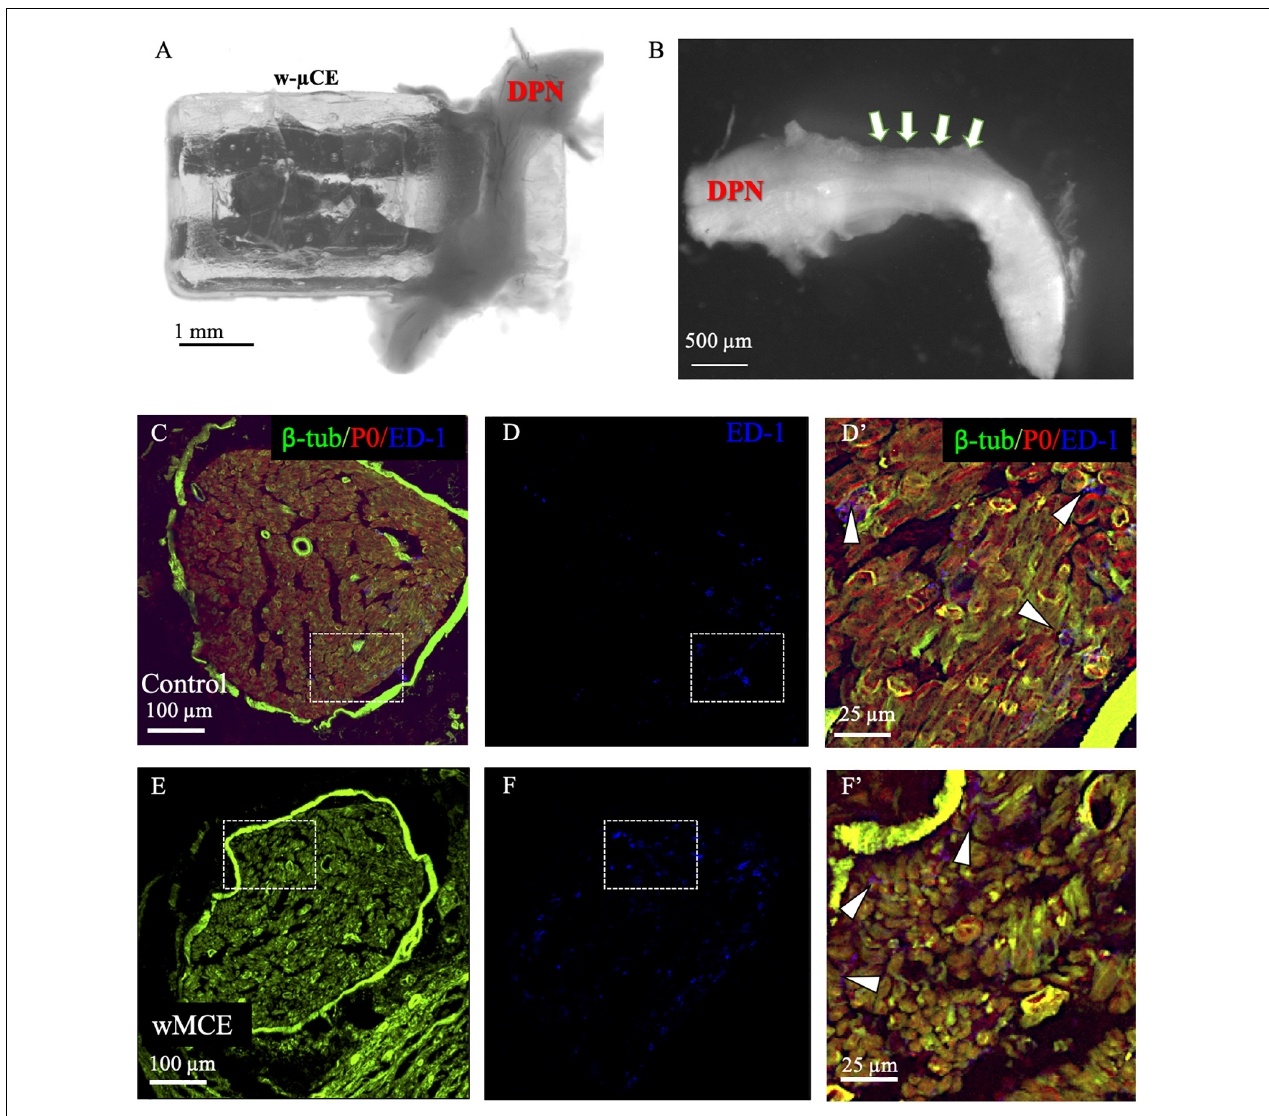
FIGURE 7 | Nerve histology after sub-chronic wMCE implantation. (a) Picture of DPN in the device 30 days after implantation. (b) Nerve segment after device removal, arrows point out the area where the electrode was implanted. Cross-section histology of control (c–d’) , and wMCE implanted DPN (e–f’) , d’ and f’ are magnifications of the dotted line squares in panel c,d and e,f , respectively. Fluorescent labels: b-tubulin (axons), P0 (myelin), ED-1 (activated